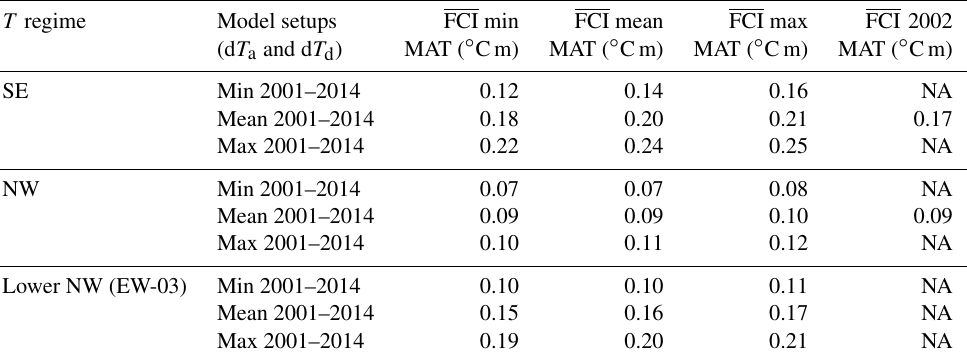
Table 2. Selected annually integrated frost cracking efficiencies ( FCI) for the studied temperature regimes and the different model runs with the respective mean annual temperatures (MAT). T : temperature; NA: not